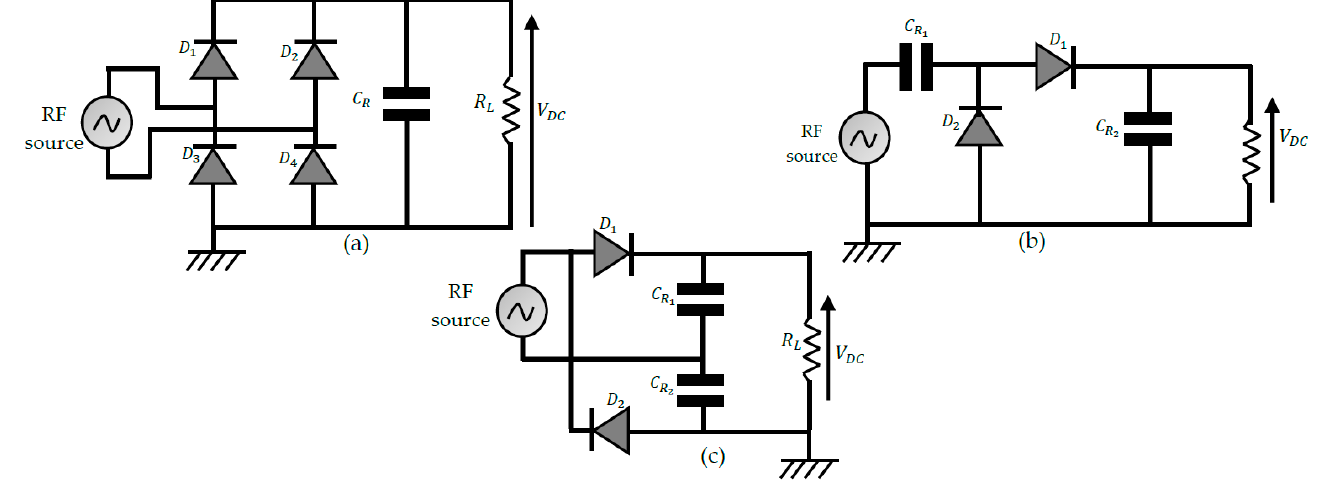
Figure 10. Full-wave rectifier topologies. ( a ) FB. ( b ). SVD. ( c ) LVD.